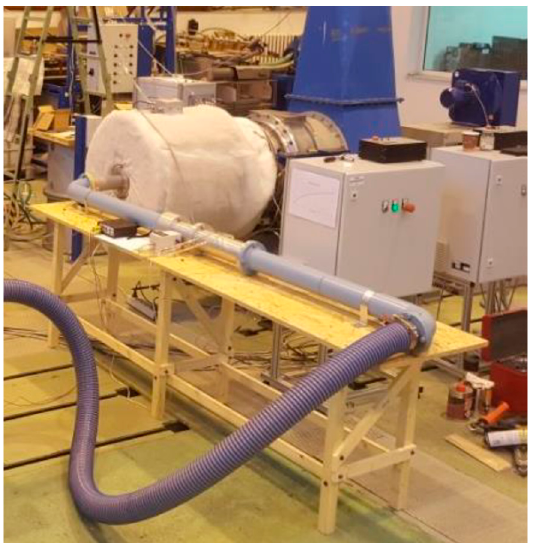
Figure 7. Extension of the VT-400 test rig with tip leakage calibration device [12].